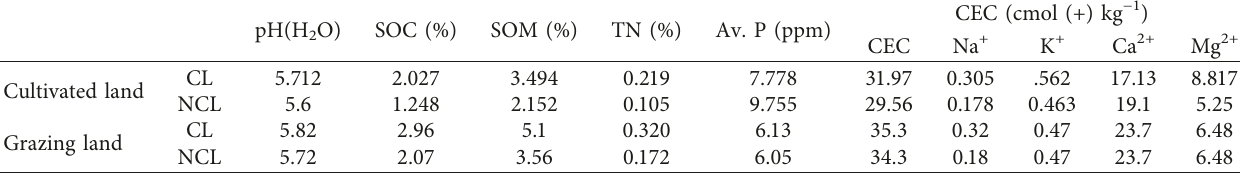
Table 4: Impact of SWC practices on soil physical properties in different land uses.